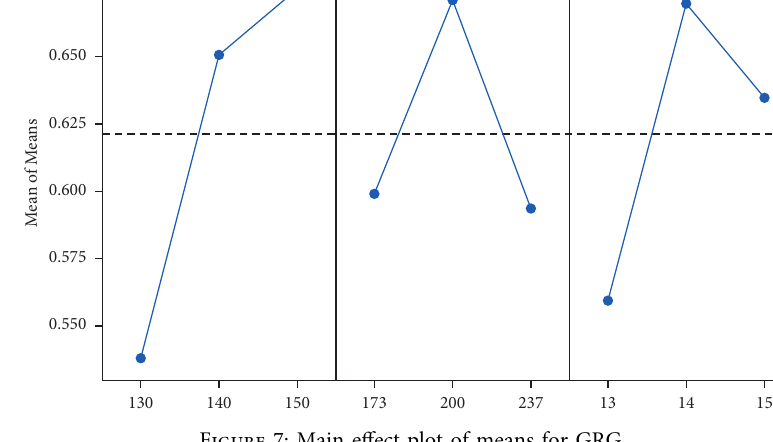
Figure 7: Main effect plot of means for GRG.